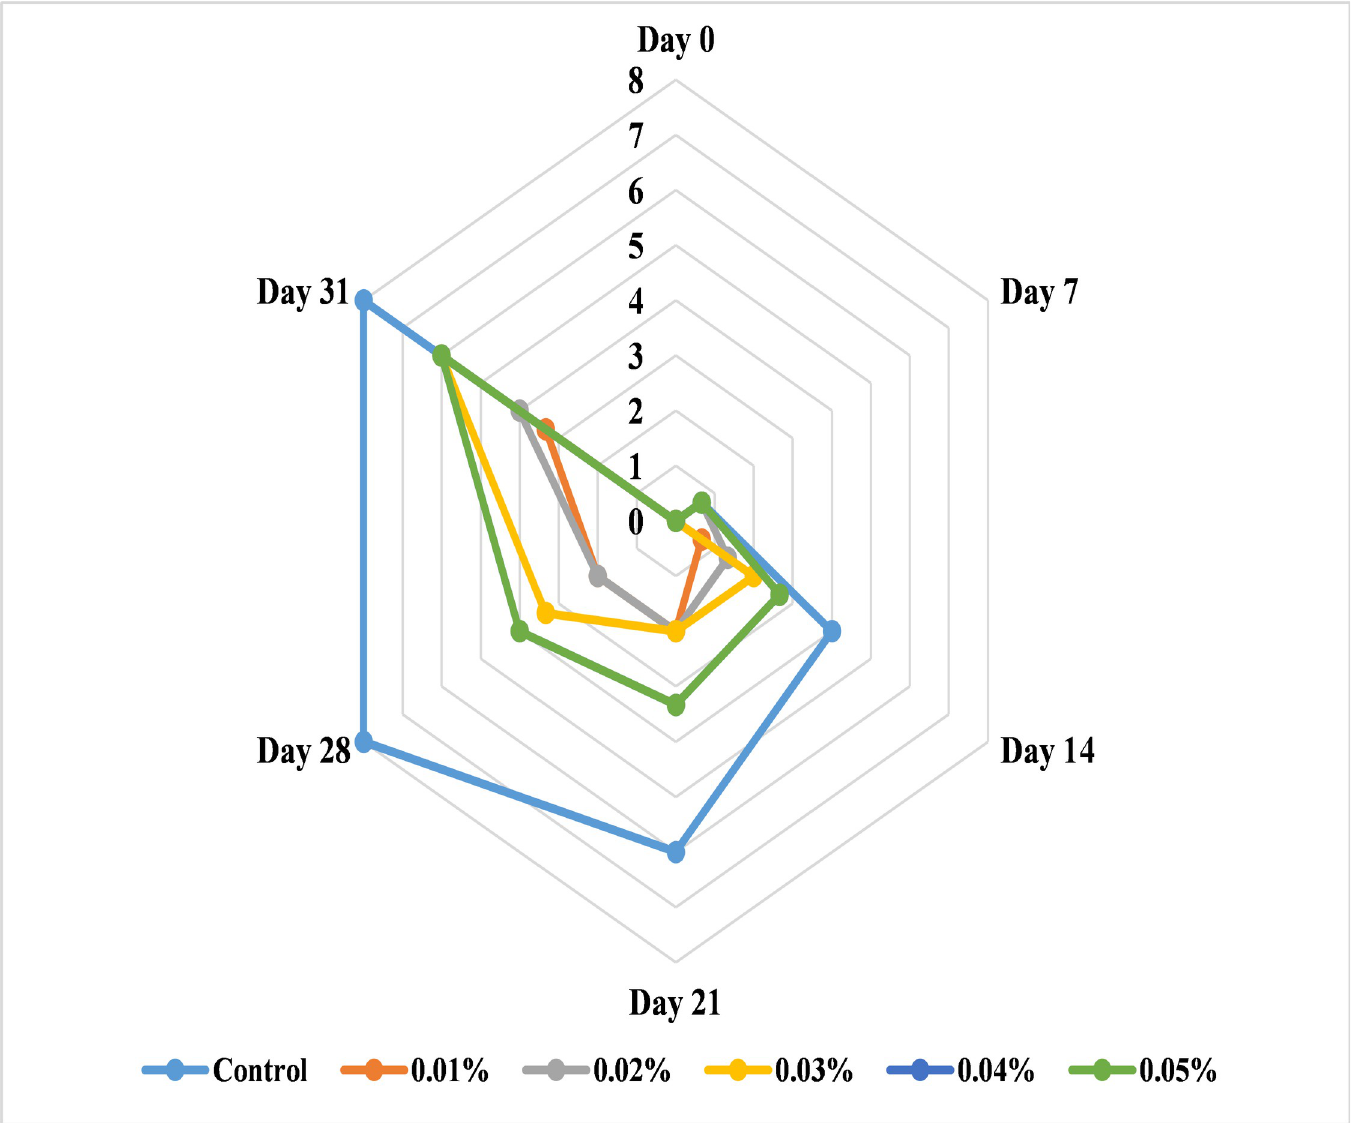
Fig 11. Effect of AgNPs concentrations (T0 = control, T1 = 0.01%, T2 = 0.02%, T3 = 0.03%, T4 = 0.04%, T5 = 0.05%) on decay of Cavendish banana (BASRAI) during 32 days of storage.